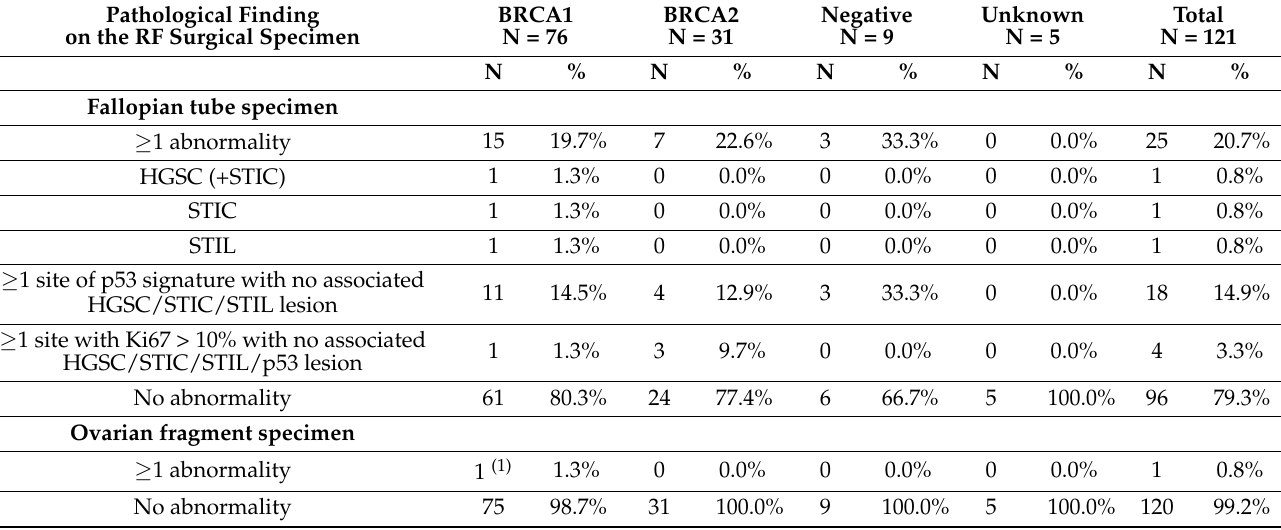
Table 3. Pathological results of RF specimens, overall and according to BRCA